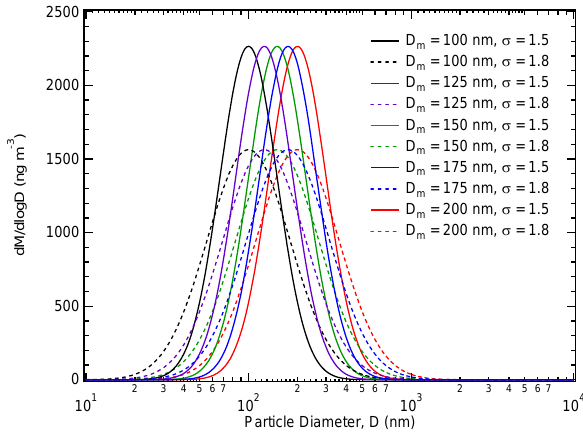
Table 1. Summary of all initial parameters used in the calculations. ∗